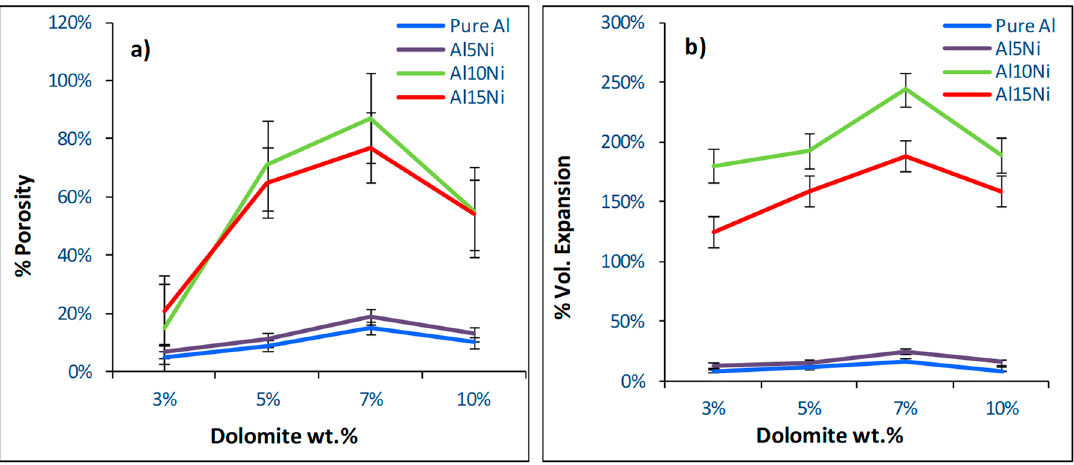
Figure 4. Porosity levels ( a ) and volume expansion ( b ) of foams containing 0 wt.% Ni (pure Al), 5 wt.% Ni (Al–5Ni), 10 wt.% Ni (Al–10Ni), and 15 wt.% Ni (Al–15Ni) as a function of dolomite content.